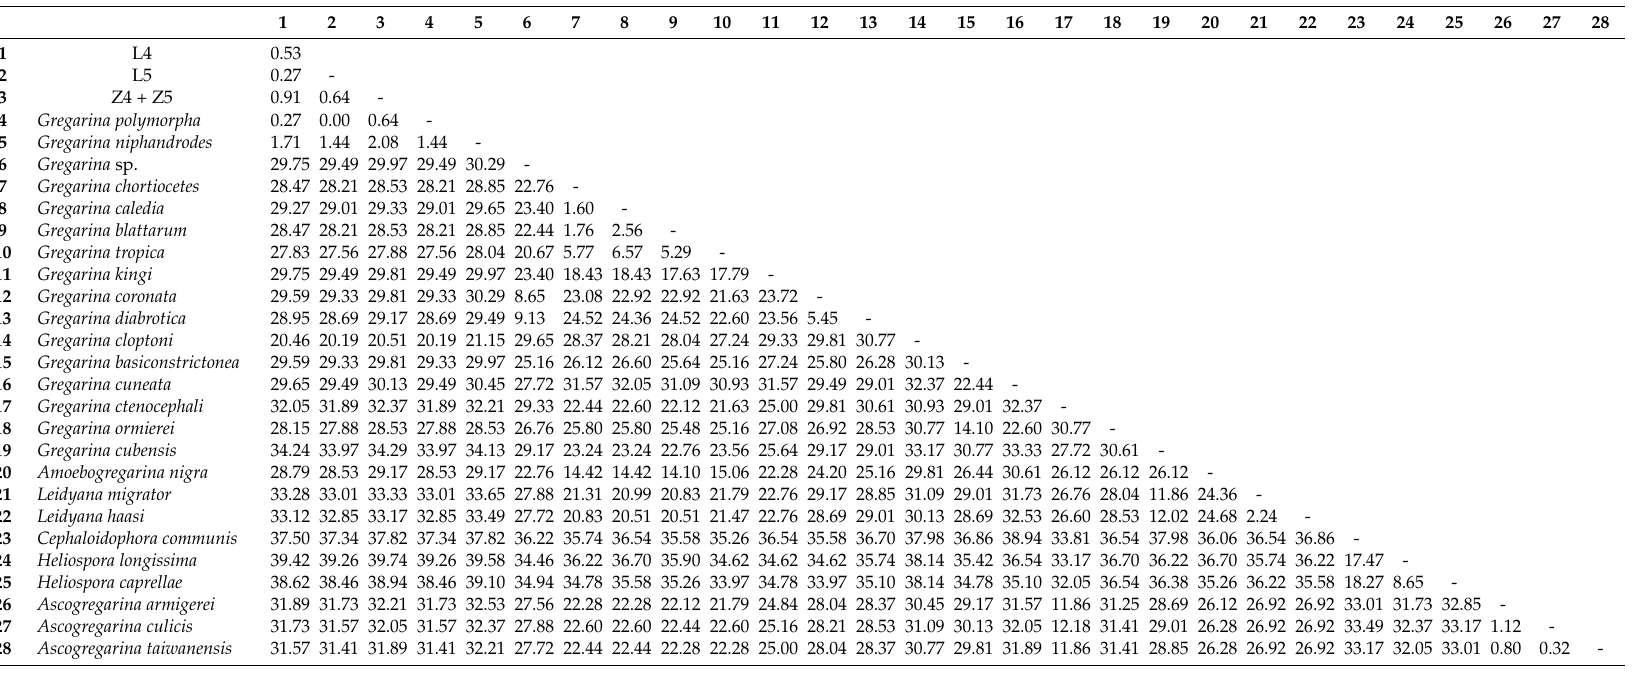
Table 5. Average p -distance values calculated when applying a “single trophozoites” ( 18S only) approach. The divergence values are assessed: between the sequences obtained in this study; among our sequences and all the Gregarina spp. for which almost the entire 18S was available on GenBank; among sequences of Gregarina spp. and five outgroup genera (number